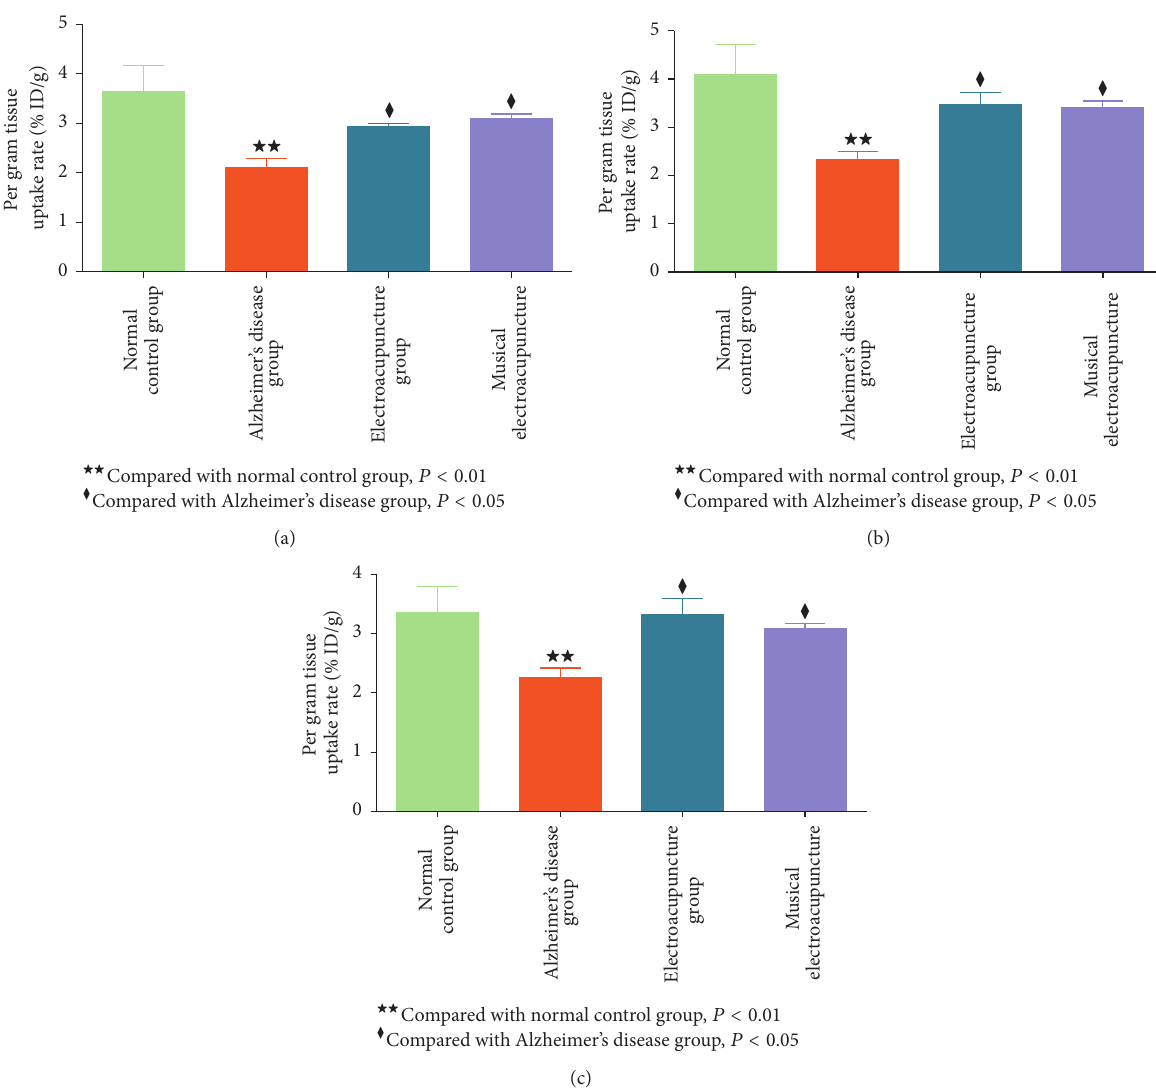
Figure 5: (a) The uptake rate of 18 F-FDG per gram in the frontal lobe of each group. (b) The uptake rate of 18 F-FDG per gram in the hippocampus of each group. (c) The uptake rate of 18 F-FDG per gram in the cerebral cortex of each